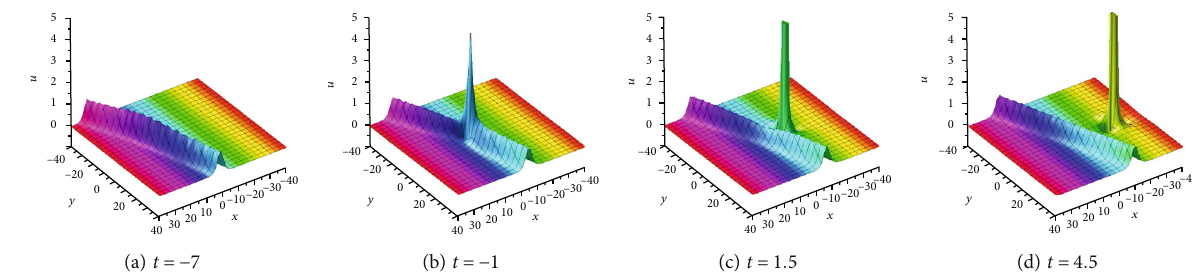
Figure 13: Lump soliton pursuit and single soliton.